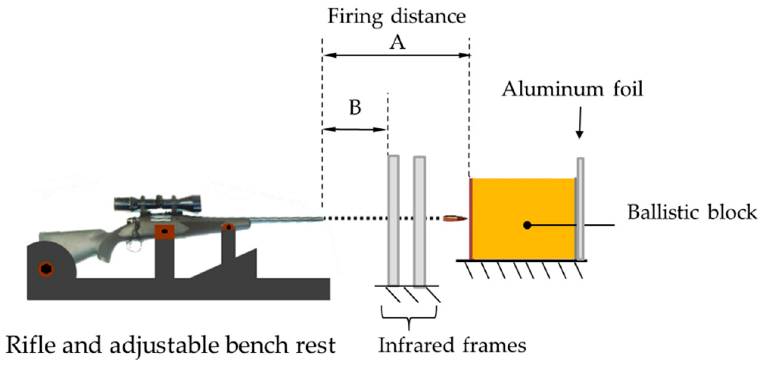
Figure 1. Configuration of the ballistic workbench.